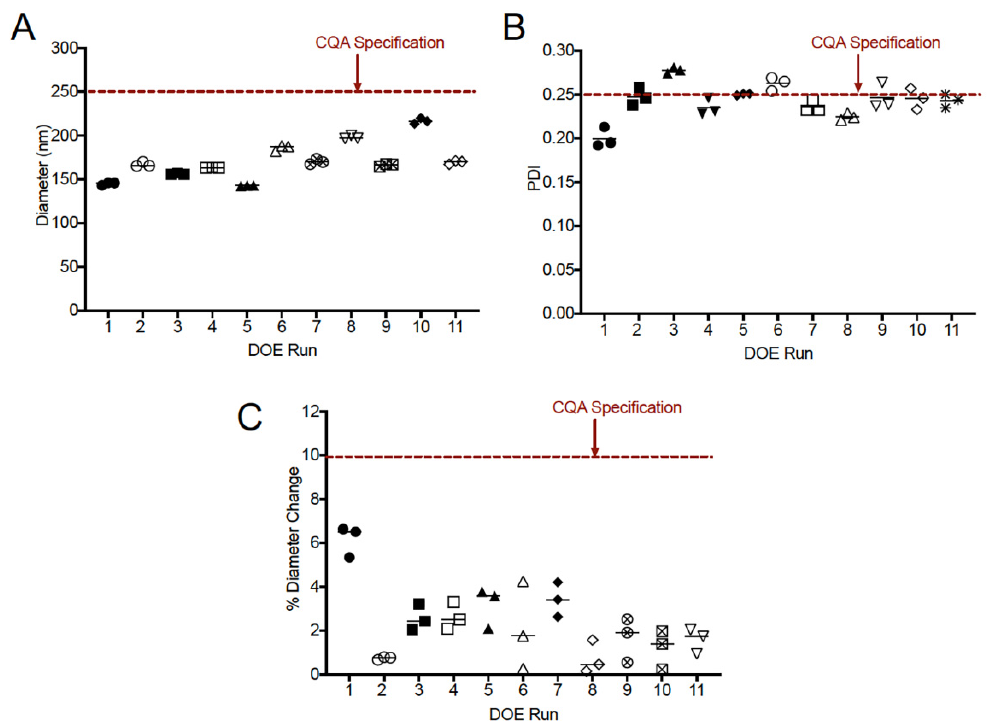
Values that meet the CQA specification are highlighted in grey. * Center point runs.